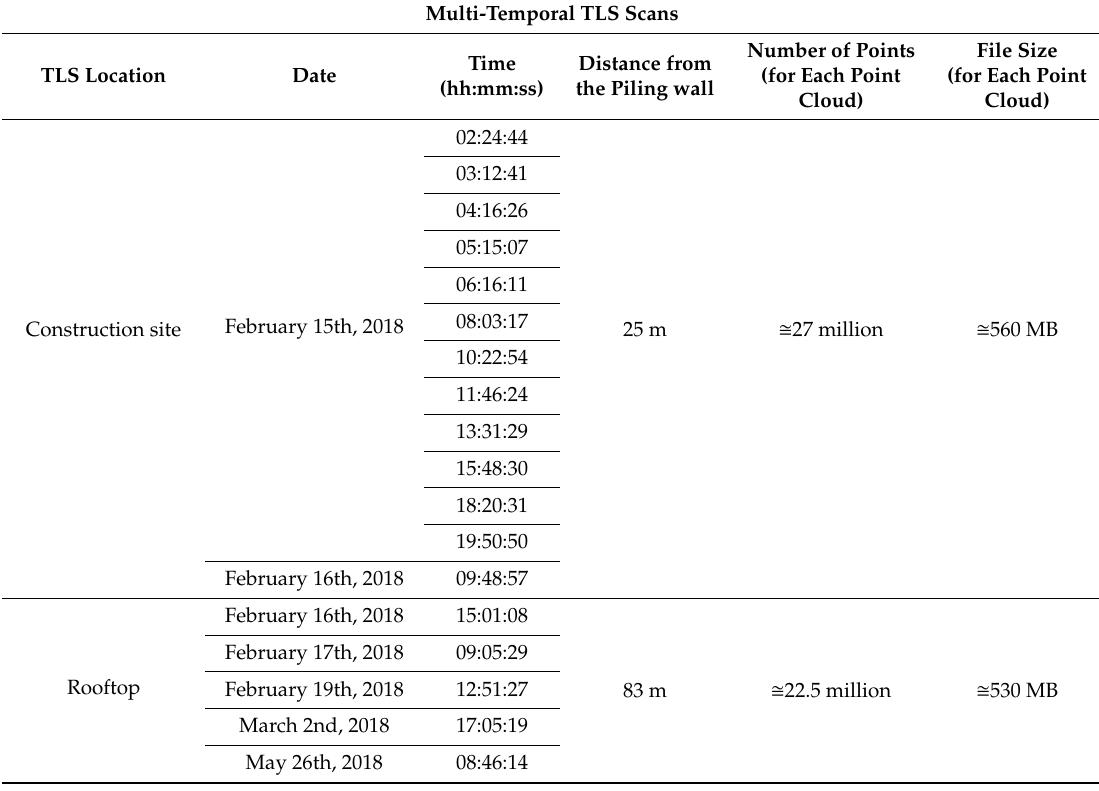
Table 1. Details of the multi-temporal scans performed by using Terrestrial Laser Scanner